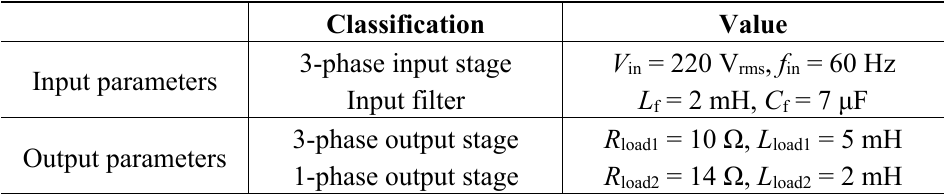
Table 1. System parameters.